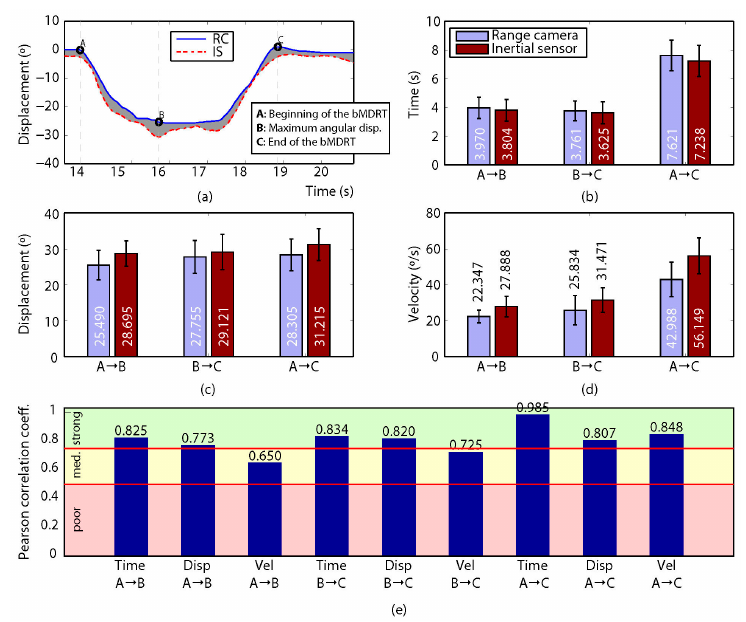
Figure 5. Results for the leftward MDRT. ( a ) Comparison of the measured displacement provided by the depth camera (solid blue) and the inertial sensor (dashed red) for a representative participant. The positions of the defined control points are also shown; ( b – d ) mean time (with CI 95%), mean angular displacement (with CI 95%) and mean angular velocity (with CI 95%), respectively, over all the participants for the intervals defined by the control points; ( e ) Pearson Correlation Coefficient (r) (p < 0.005) between the devices for all the measured variables. (Time is expressed in seconds, angular displacement in degrees, and angular velocity in degrees per second).